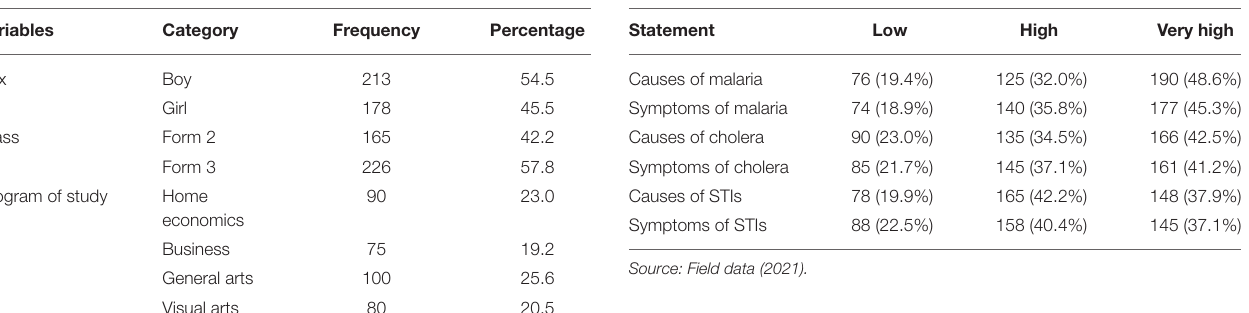
TABLE 3 | Sociodemographic characteristics of respondents ( N = 391). TABLE 4 | Level of knowledge on the sign and symptoms of common